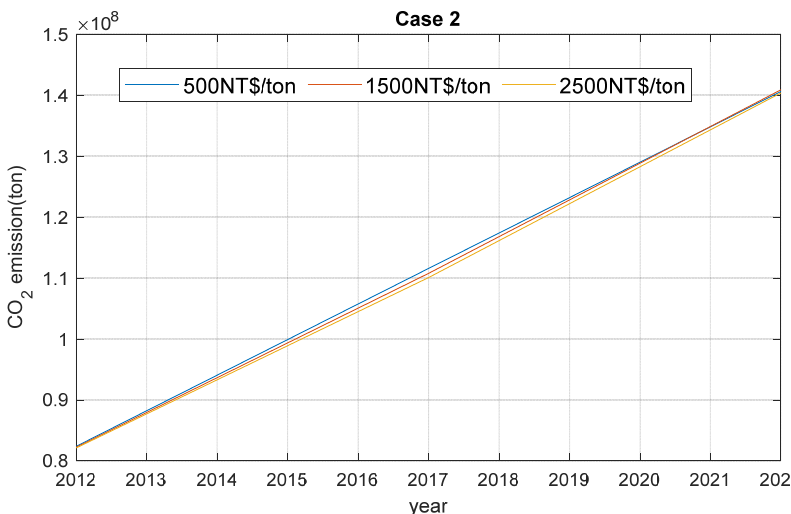
Figure 3. The relationship between emissions and time in the analysis of Case 2. Table 6. The generation of plants among the various fossil ‐ fired plants in case 2. The Generation of Plants in 2012